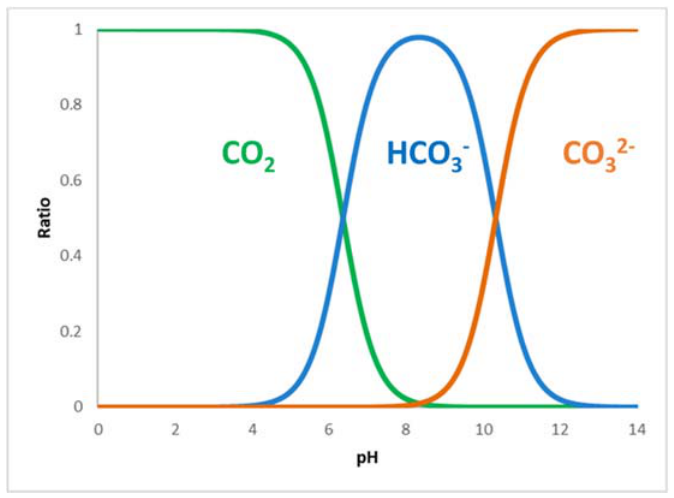
Figure 2: Distribution of species derived from CO 2 according to pH in water solution [19]. Figure 2. Distribution of species derived from CO